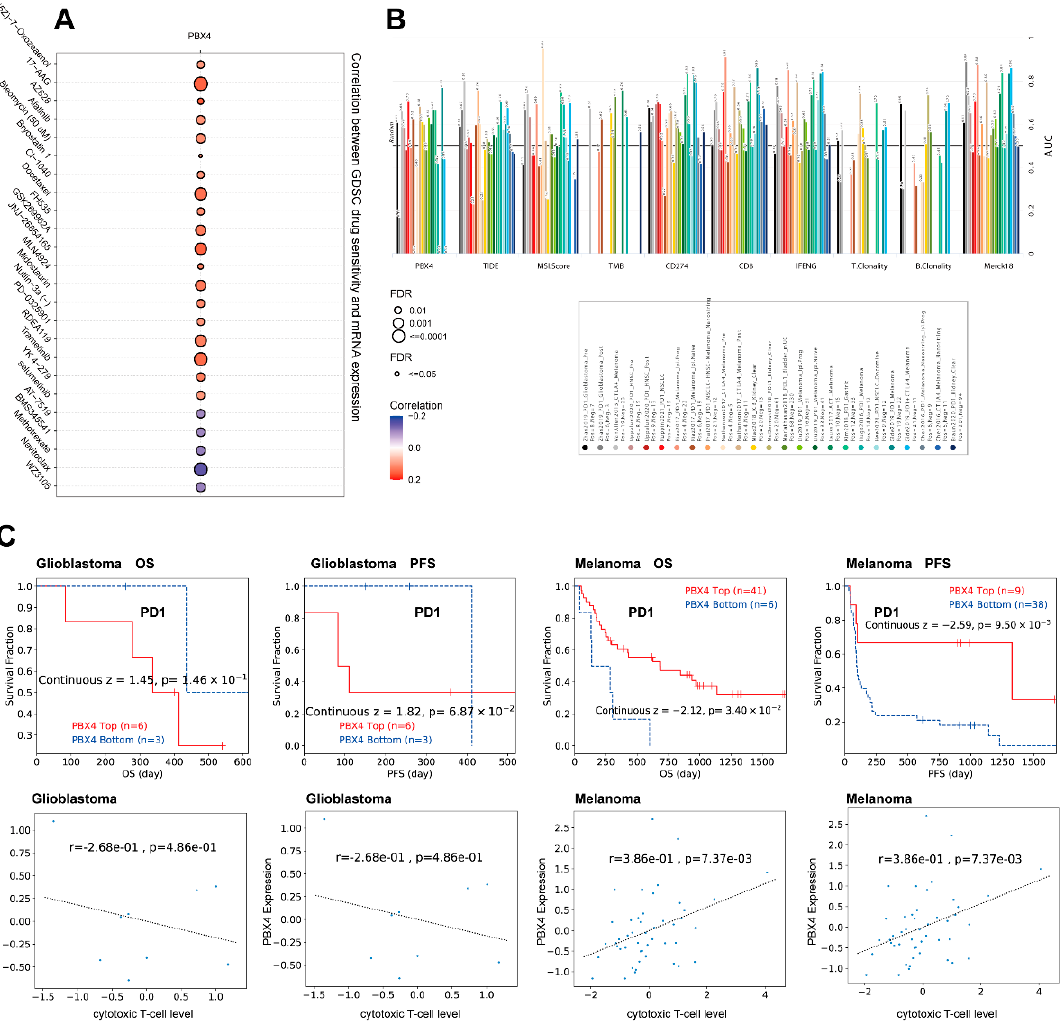
Figure 12. Therapy analysis of PBX4 in different cancer types. ( A ) Drug sensitivity analysis of PBX4 expression in the GDSC database. ( B ) The difference between PBX4 and existing biomarkers in immune checkpoint blockade. ( C ) Correlation between PBX4 expression with cytotoxic T-cell levels and survival curve of immunotherapeutic response.